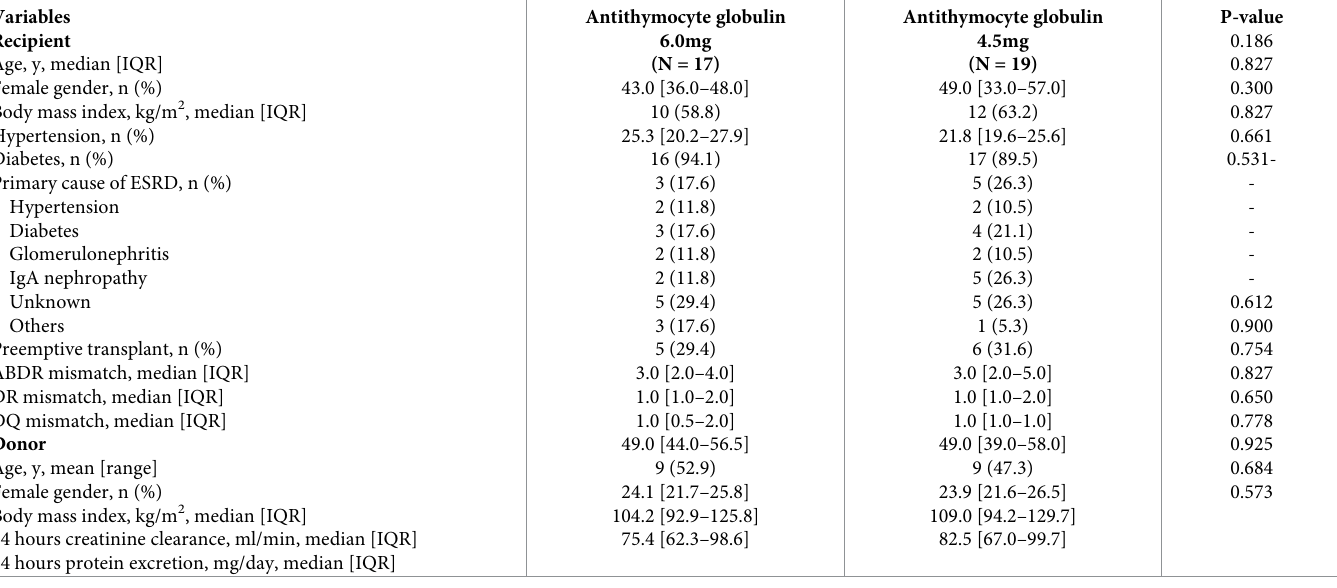
Table 1. Baseline characteristics according to the dosage of antithymocyte